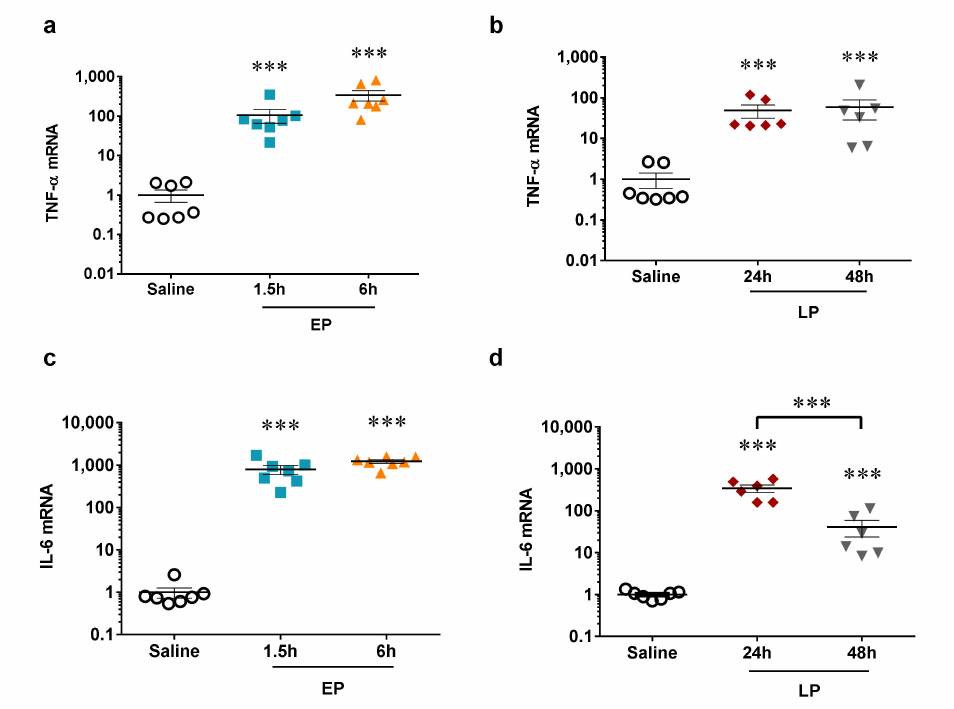
Figure 1. The relative mRNA expression of pro-inflammatory proteins after lipopolysaccharide (LPS) injection normalized to GAPDH (fold changes vs. saline). ( a , b ) TNF- α mRNA ( a ) early phase (EP), 1.5 and 6 h, ( b ) late phase (LP), 24 and 48 h, ( c , d ) IL-6 mRNA ( c ) EP, 1.5 and 6 h, ( d ) LP, 24 and 48 h. Data are expressed as mean ± SEM; one-way ANOVA; ***: p <